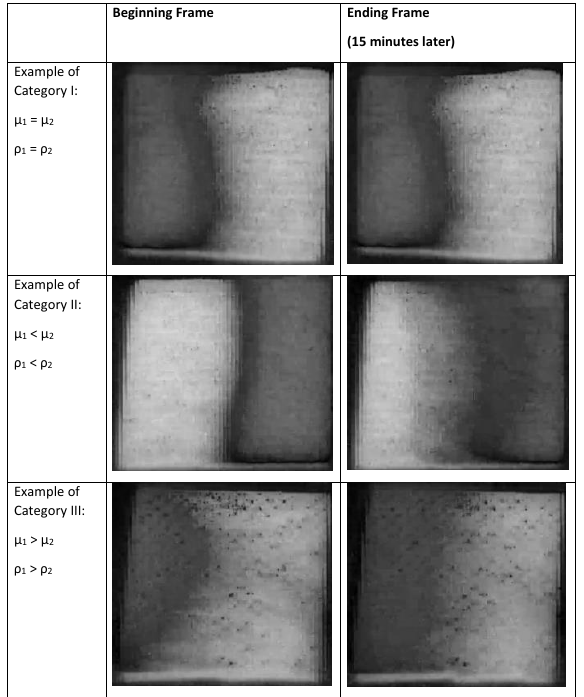
Figure 14. Saturation values of the first and final frame (after 15 min) using the saturation component of the HSB image after converting from RGB in ImageJ. The three categories of fluid filling are based on having two miscible fluids with the same or different values of viscosity and density.